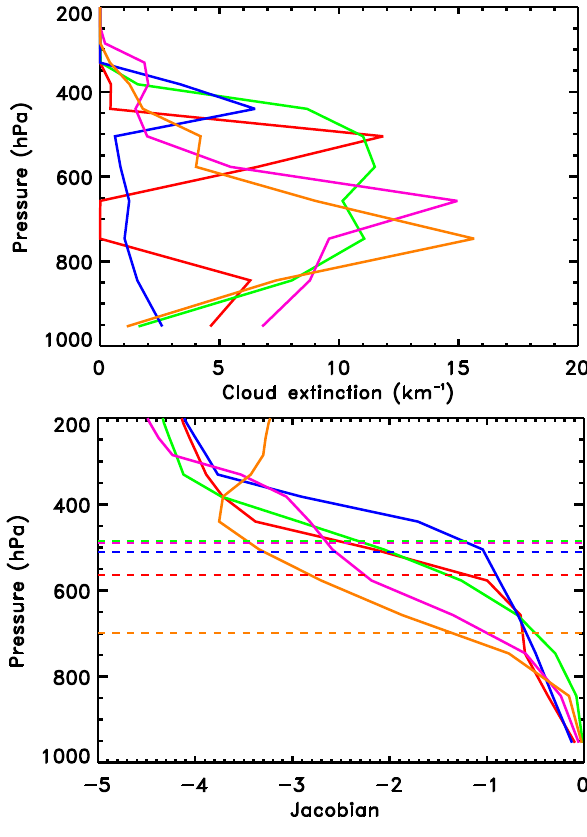
Fig. 10. Top: CloudSat/MODIS cloud extinction for cases de- scribed in Table 3; Bottom, solid lines: corresponding ozone Jaco- bian, ∂ ln (I)/∂τ l ( O 3 ) ; dashed lines: OMI retrieved optical centroid cloud pressures